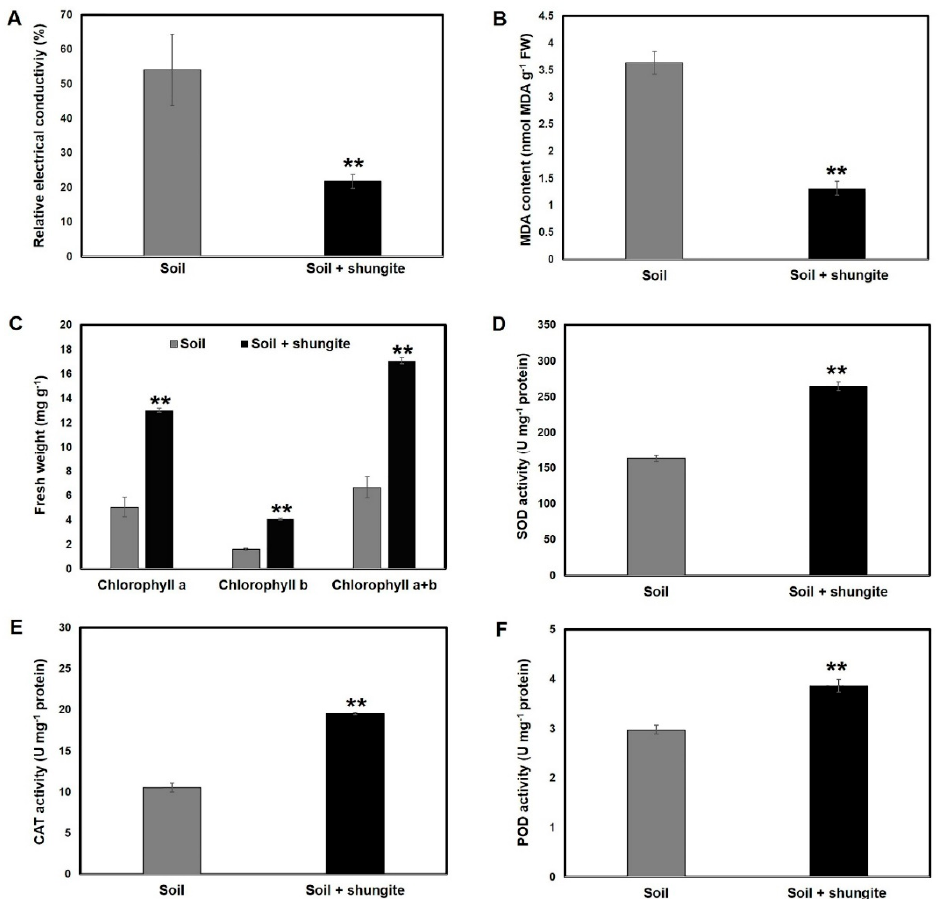
Figure 3. Effects of shungite on physiological indicators of drought tolerance in cucumber. ( A ) Determination of relative electrical conductivity. ( B ) Comparative analysis of MDA accumulation in cucumber leaves. ( C ) Determination of total chlorophyll content in the same leaf area (3 cm 2 ). ( D – F ) Comparison of ROS scavenger activity under drought stress. The leaf SOD, POD, and CAT activities in cucumber plants. Experiments were performed using three randomly collected leaves from 18 plants on day 21, at which point severely wilted plants were observed in the control group. All experiments were performed in triplicate, and the average is represented in graph. Error bars represent the mean ± SD. Asterisks indicate statistical significance (Student’s t -test, ** p ≤ 0.05). MDA: